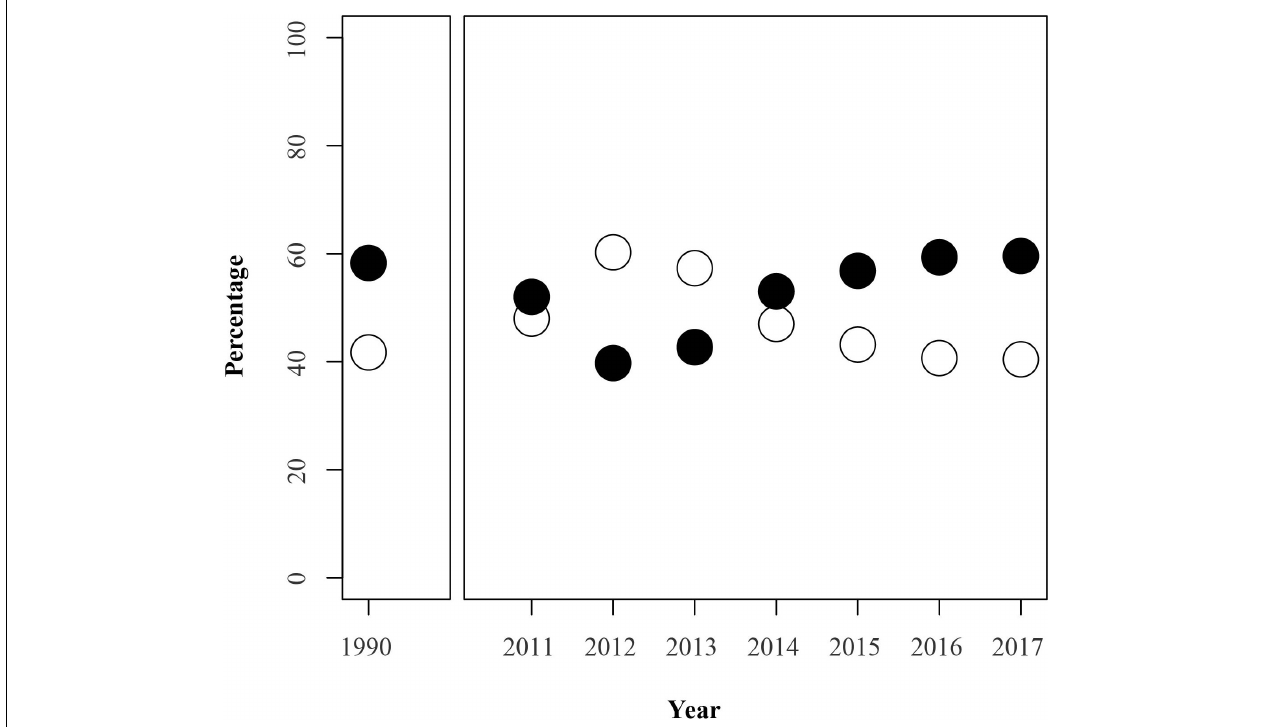
FIGURE 1 | Changes in the observed frequency of light (white) and dark (black) individuals of L. fabalis for a range of years in the population of Abelleira (NW Spain). Data of 1990 obtained from Rolán-Alvarez and Ekendahl (1996).